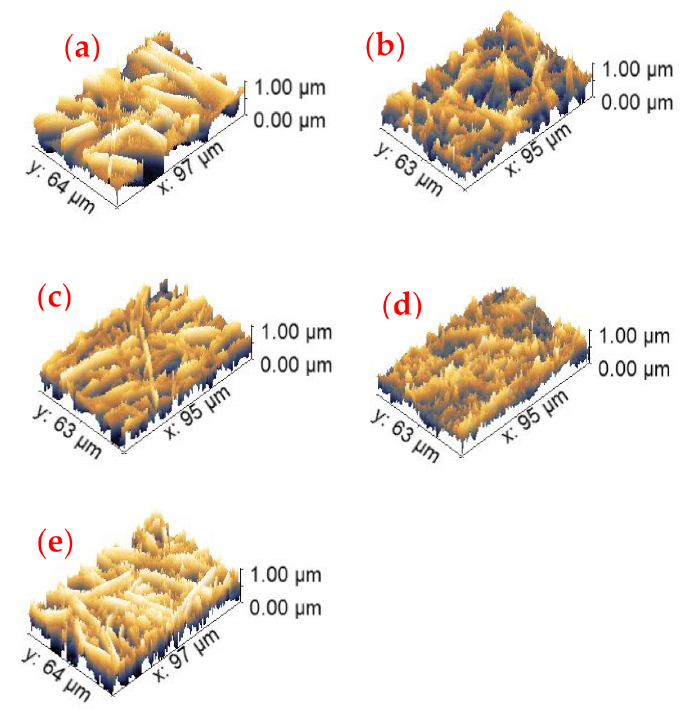
Figure 7. ( a – e ) Surface Roughness of PCL scaffolds encapsulated with Ag/V-HAP at different additional Ag ions: ( a ) 0.0 Ag/V-HAP@PCL, ( b ) 0.2 Ag/V-HAP@PCL, ( c ) 0.4 Ag/V-HAP@PCL, ( d ) 0.6 Ag/V-HAP@PCL, ( e ) 0.8